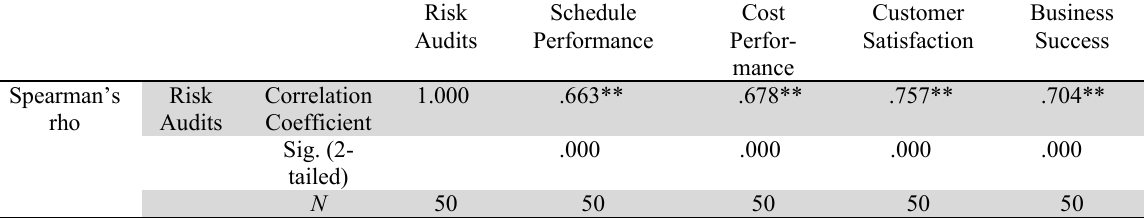
Correlations: Risk Audits and Project Success Outcomes (Schedule Performance, Cost Performance, Customer Satisfac- tion, and Business Success)